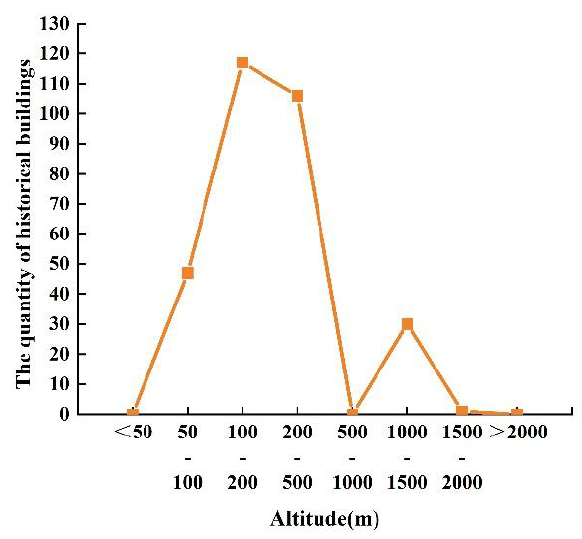
Figure 11. Quantitative distribution of historical buildings in the different altitude ranges.